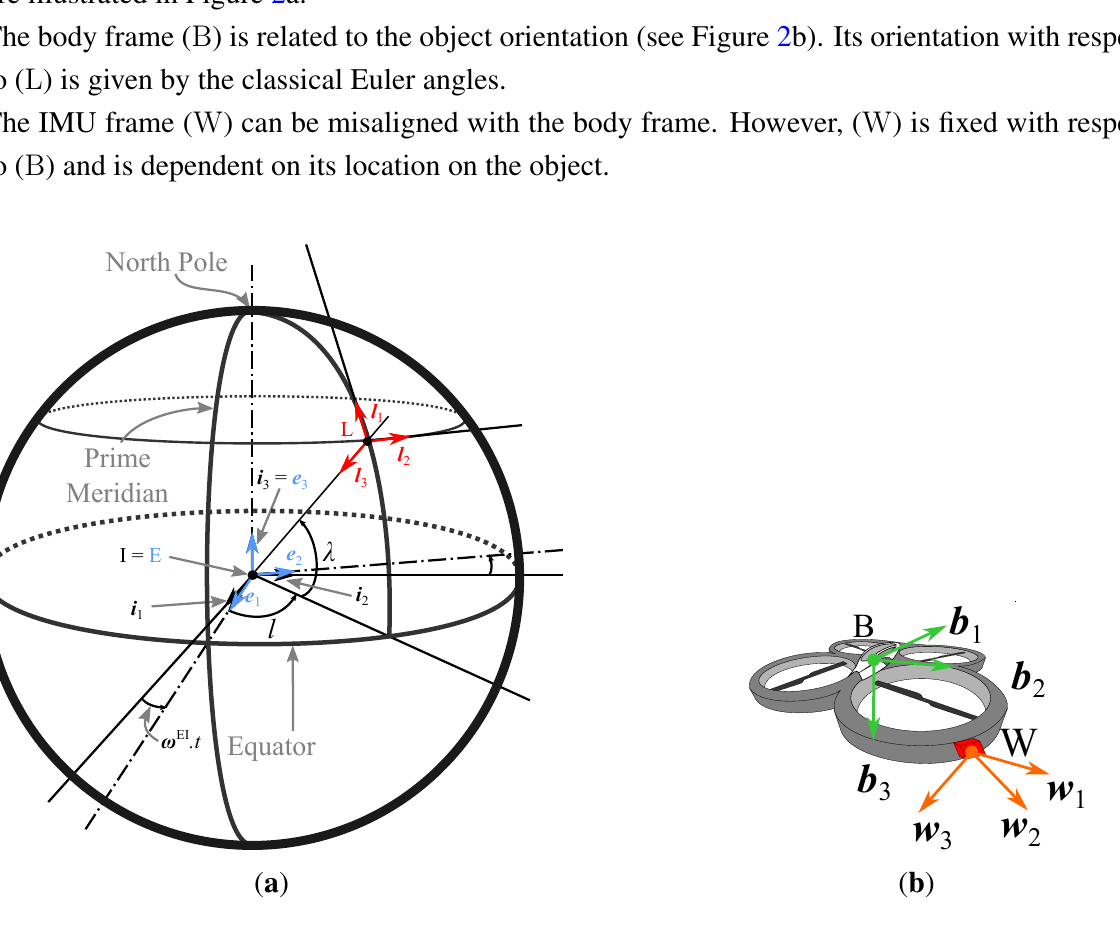
Figure 2. Illustration of the different frames: inertial frame (I), Earth frame (E), local frame (L), body frame (B) and work frame (W).( a ) Inertial, Earth and local frames; ( b ) Body and work